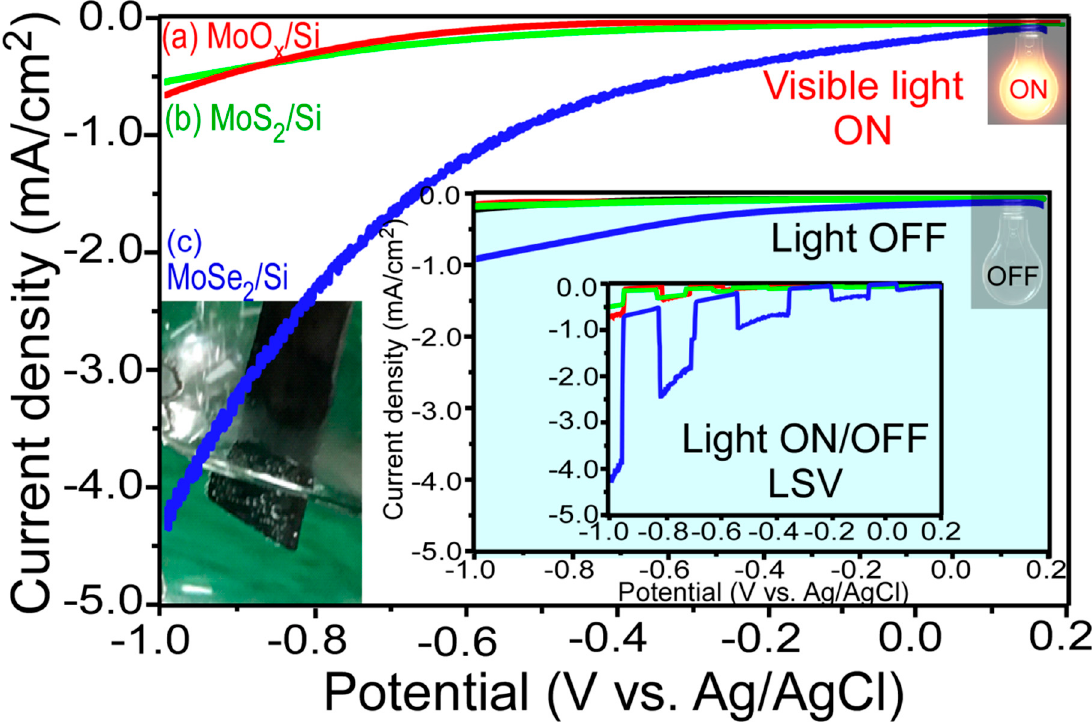
Figure 4. Linear sweep voltammetry curves (voltage range: +0.2 ~ 1.0 V) at a scan rate of 10 mV/sec) under visible light exposure for (a) MoO x / Si, (b) MoS 2 / Si and (c) MoSe 2 / Si samples. Inset LSV curves were taken under the dark condition. The corresponding light ON-and-OFF LSV curves are displayed in the inset. Inset photo shows the bubble formed on the catalyst surface during LSV.